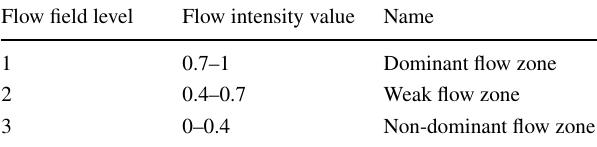
Table 1 Standard of flow field intensity